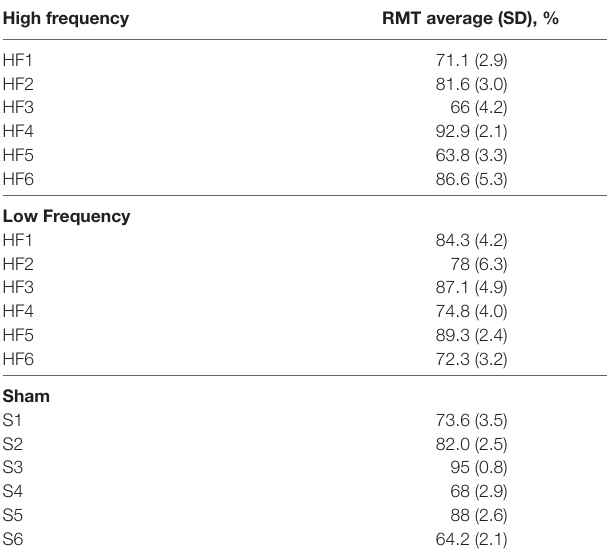
TaBle 3 | Resting motor threshold (RMT) per subject. TaBle 2 | The number of choices participants made for smoked cocaine by